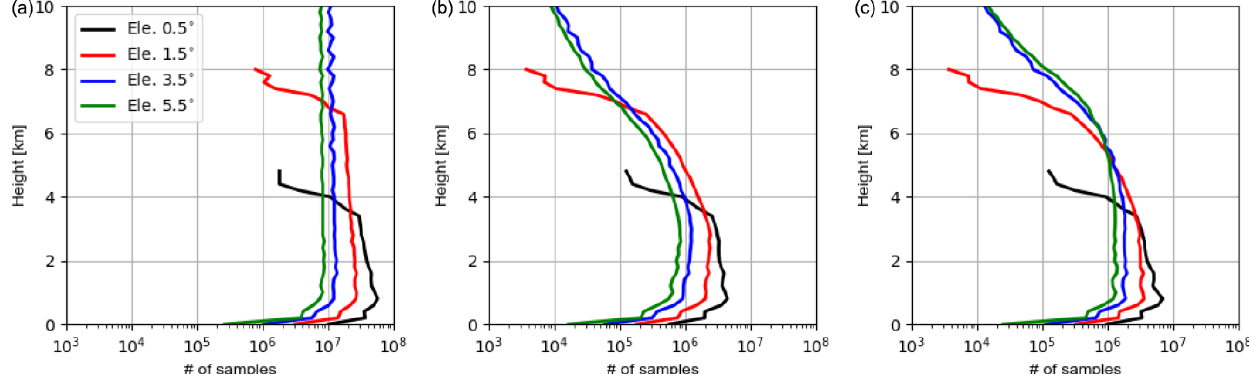
Figure A1. Vertical profiles of numbers of samples used for estimating standard deviations of the RE for reflectivity data ≥ (a) and ≥ 5dBZ (b) and for radial wind (c) at elevations of 0 . 5, 1 . 5, 3 . 5 and 5 . 5 ◦ .